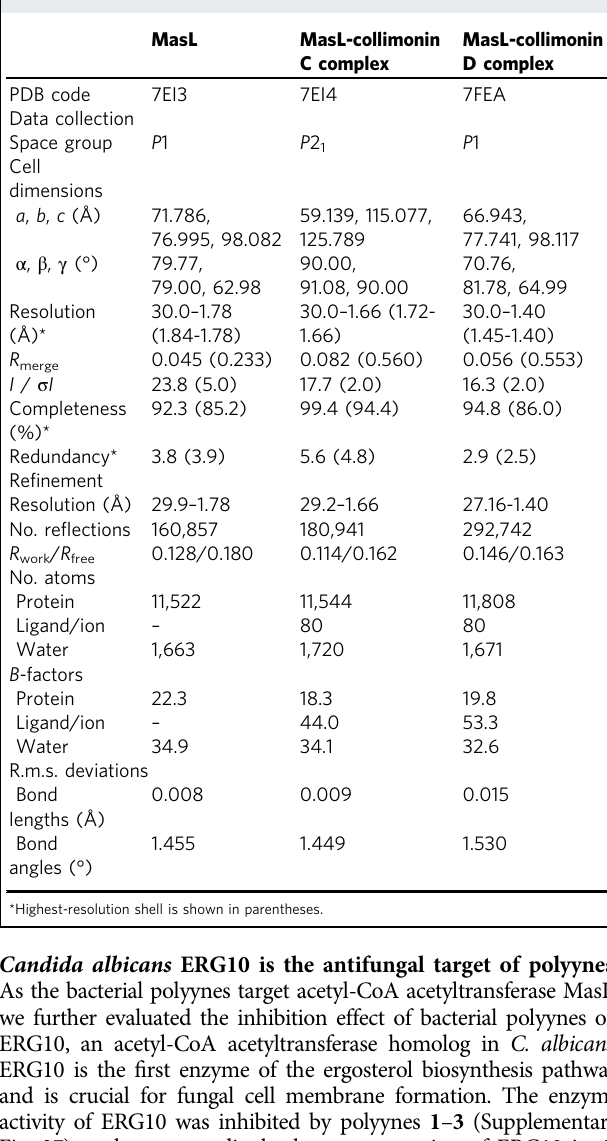
Table 2 X-ray data collection and re fi nement statistics.